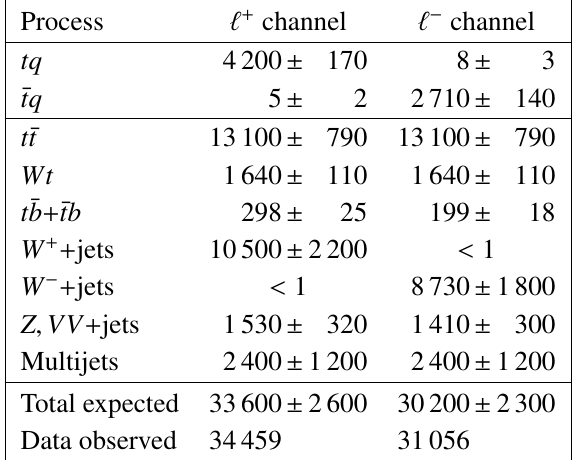
Table 1 . Predicted and observed event yields for the signal region. The quoted uncertainties include uncer- tainties in the theoretical cross-sections, in the number of multijet events, and the statistical